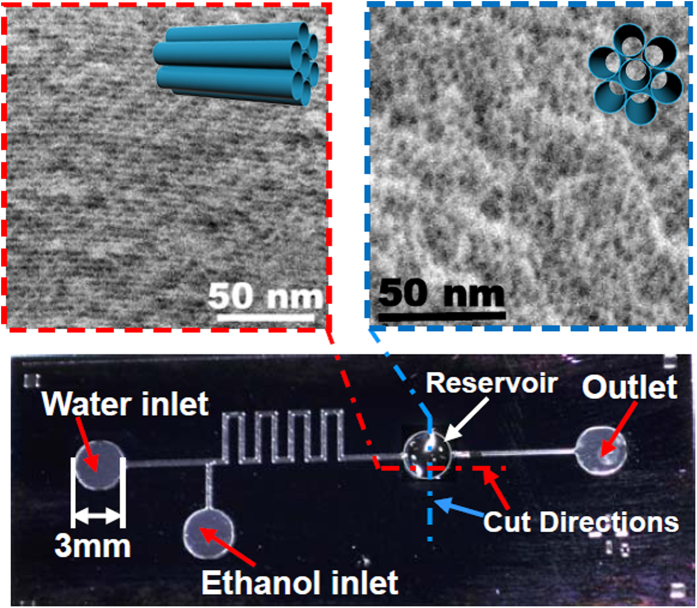
Top-view photograph of the extraction/enrichment microfluidic chip.The mesoporous-silica nano-channels in the reservoir are characterized by high-resolution SEM. The two cross-sectional SEM images are with the sample cut along the two directions denoted in the figure. The SEM at the left-side shows the longitudinal direction of the nano-channels and the right one shows the transverse direction of the channels where the nano-pore entrances can be seen.